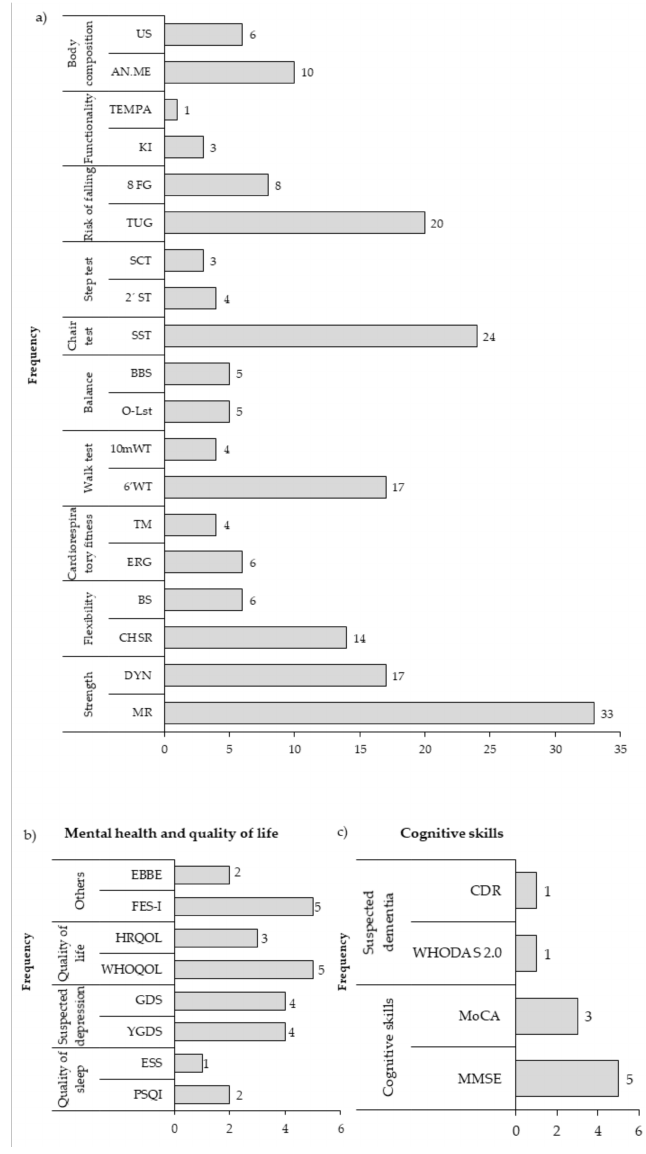
Figure 4. Instruments for measuring ( a ) Physical Health variables. Strength: MR, Maximum repetition; DYN, Dynamometer. Flexibility: CHSR, Chair sit and reach; BS, Back Scratch. cardiorespiratory fitness: ERG. Ergospirometry; TM, Treadmill. Walk test: 6’WT, 6-min walk test; 10 mWT, 10-m walk test. Balance: O-Lss, One-legged stand test; BBS, Berg Balance Scale. Chair test: SST, Sit to Stand Test. Step Test: 2’ST, 2 min Step Test, SCT, Stair Climb Test Risk of falling: TUG, Time up and go; 8FG, 8-fit and go. Functionality: KI, Katz index; TEMPA, Test d’Evaluation des Membres Sup é rieurs de Personnes Â g é es. Body composition: ANT. ME., Anthropometric measures; US, Ultrasound. ( b ) Mental health and quality of life variables. Sleep quality: PSQI, Pittsburgh Sleep Quality Index; ESS, Epworth sleepiness scale. Suspected depression: YGDS, Yesavage Geriatric Depression Scale; GDS, Geriatric Depression Scale. Quality of life: WHOQOL, The World Health Organization Quality of Life; HRQOL, Health Related Quality of Life. Others: FES-I, Falls Efficacy Scale International; EBBE, Exercise Benefits Barriers Scale. ( c ) Cognitive skills variables. Cognitive skills: MMSE, Mini-Mental State Examination; MoCA, Montreal Cognitive Assessment. Suspected dementia: WHODAS 2.0, World Health Organization Disability Assessment Schedule; CDR, Clinical Dementia Rating. The data are presented in absolute